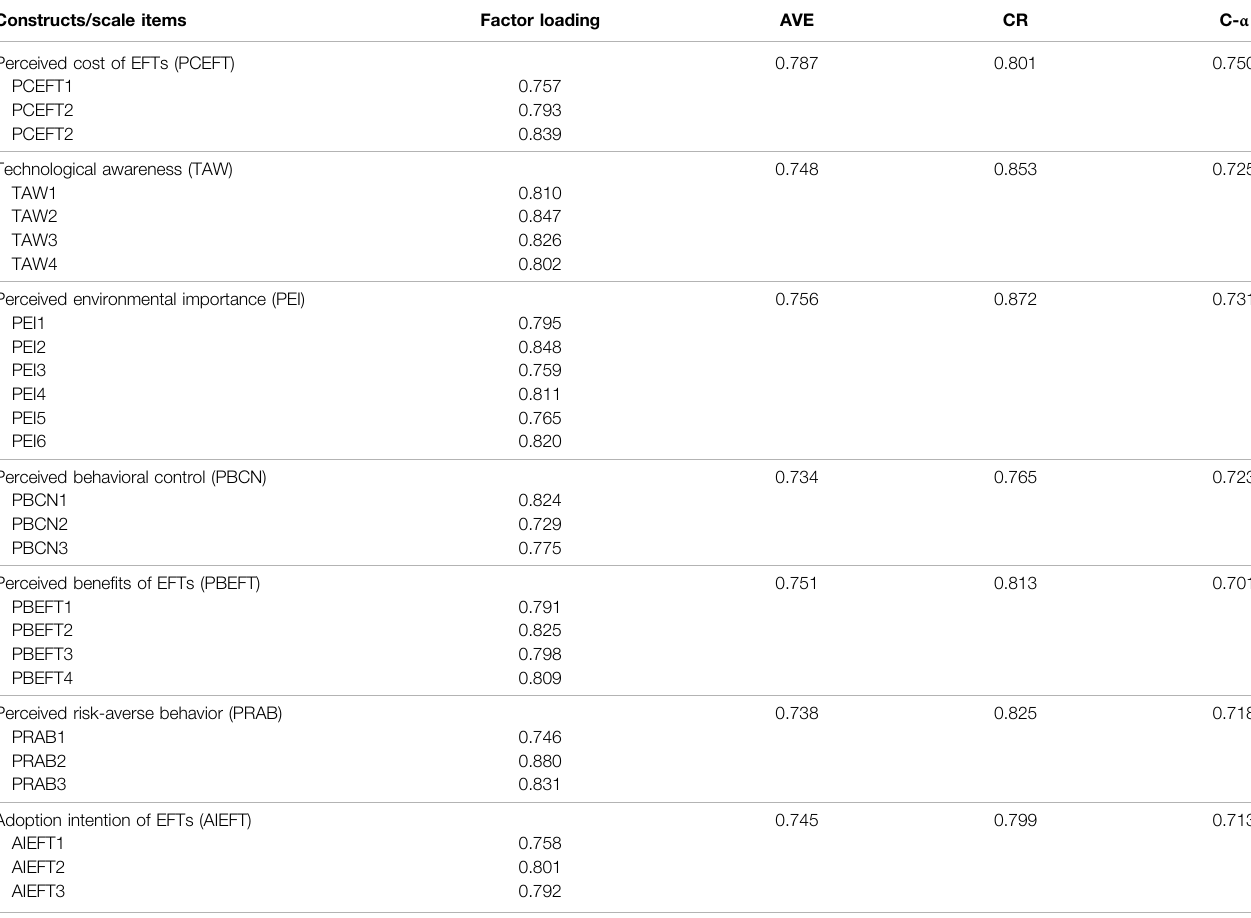
TABLE 3 | Measurement model results.